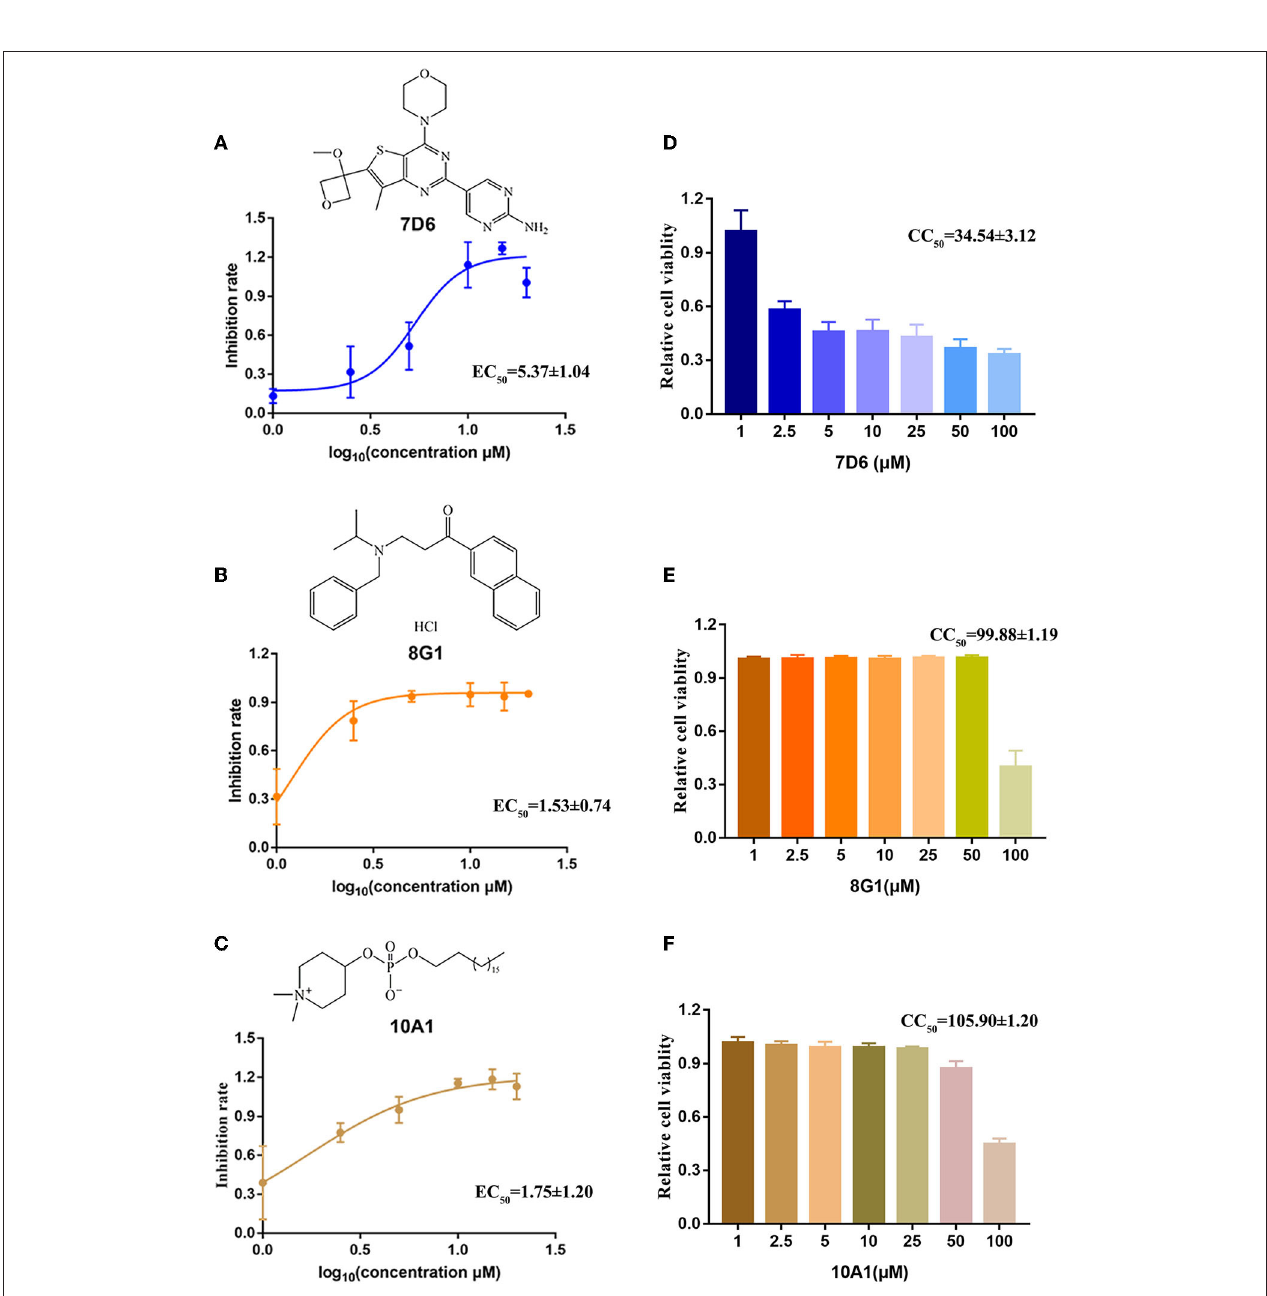
FIGURE 3 | Evaluation of the selectivity index of three kinase inhibitor candidates. The chemical structure and dose-dependent inhibitory activity of (A) compound 7D6, (B) compound 8G1, and (C) compound 10A1 against HTNV at concentrations ranging from 1 to 20 µ M. The half cytotoxicity concentration of (D) compound 7D6, (E) compound 8G1, and (F) compound 10A1 was measured at a concentration ranging from 1 to 100 µ M, n = 3.